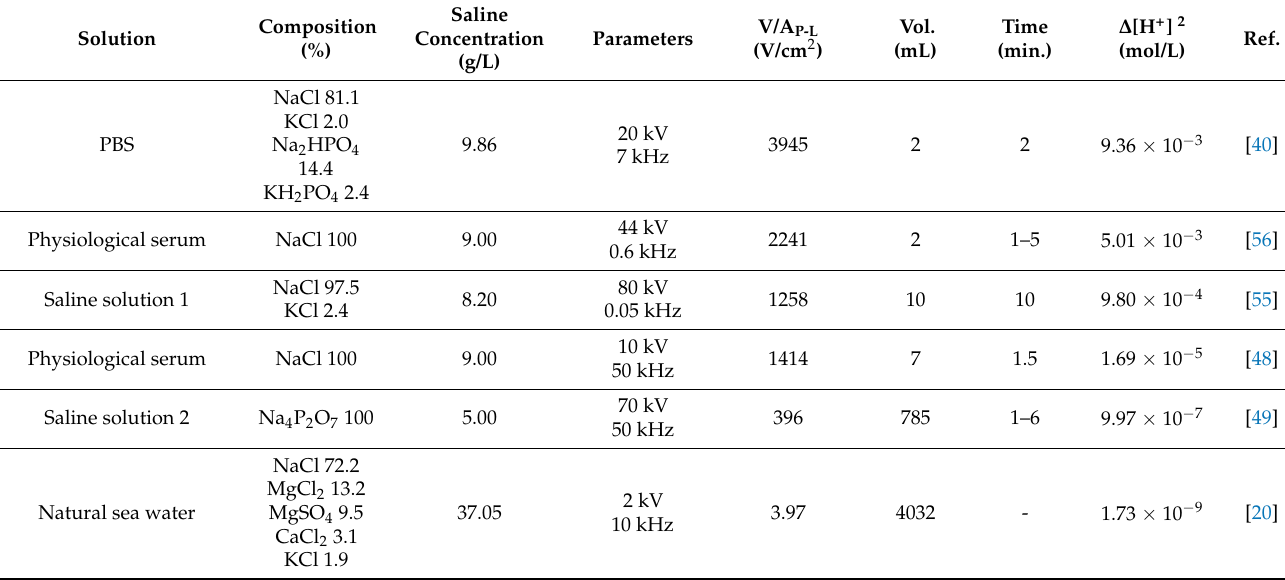
Table 3. Acidification of saline water by